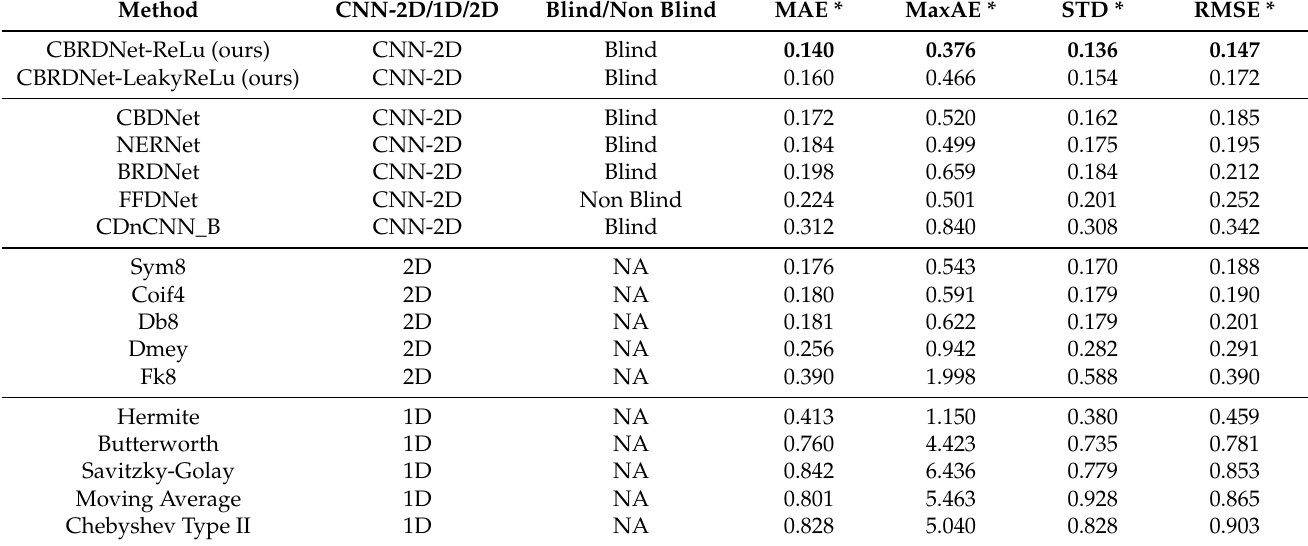
Table 2. Comparative results of our approach with both traditional 1D and 2D denoising approaches and 2D denoising CNN methods. MAE = mean absolute error; MaxAE = maximum absolute error; STD = standard deviation of the absolute error; RMSE = root mean squared error. Best results presented in bold font.